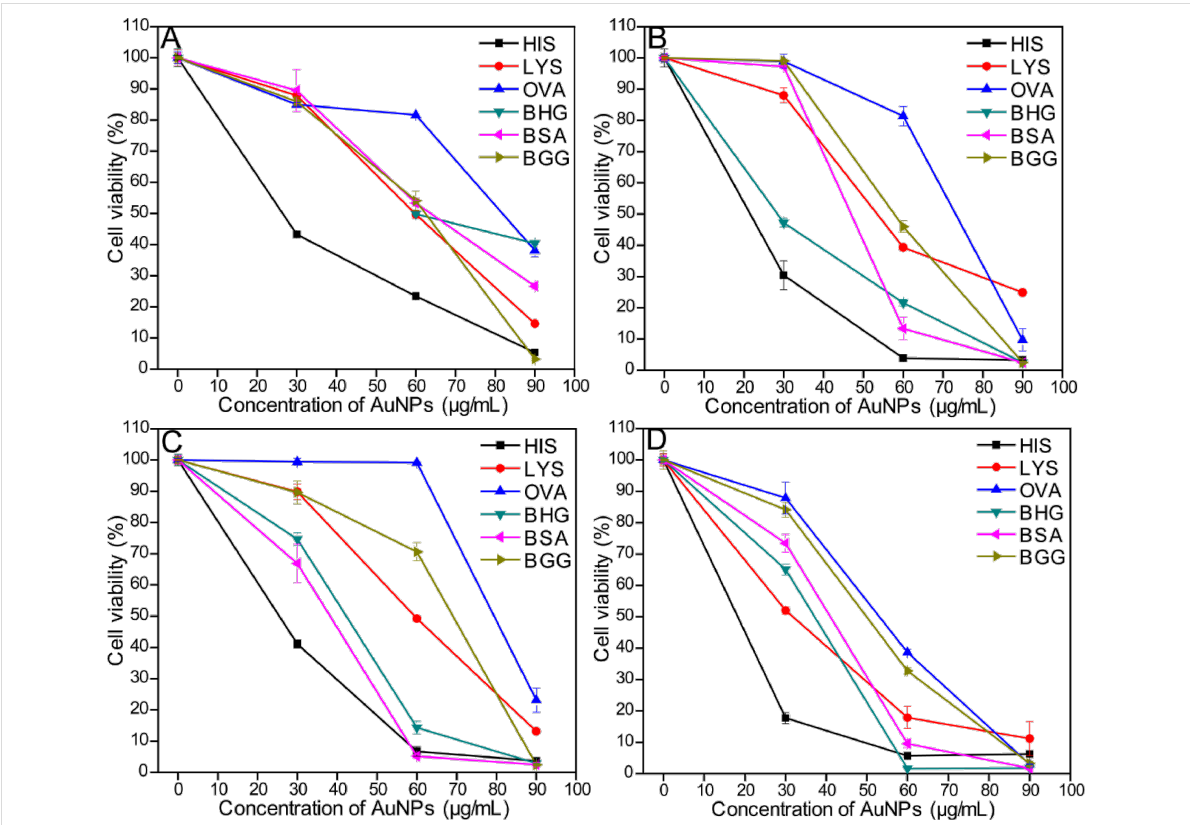
Figure 4: Cell viability studies by using MTT assay on (A) NIH-3T3, (B) HCT116, (C) HeLa and (D) SCC-7 cells treated with AuNPs prepared by using different proteins.